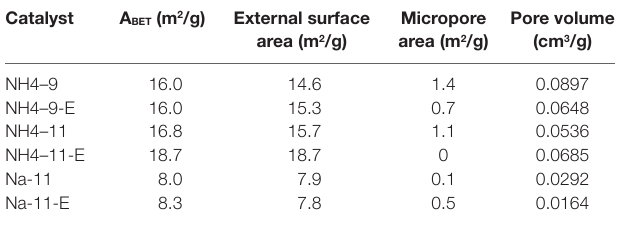
Table 1 | Textural properties of fresh calcined